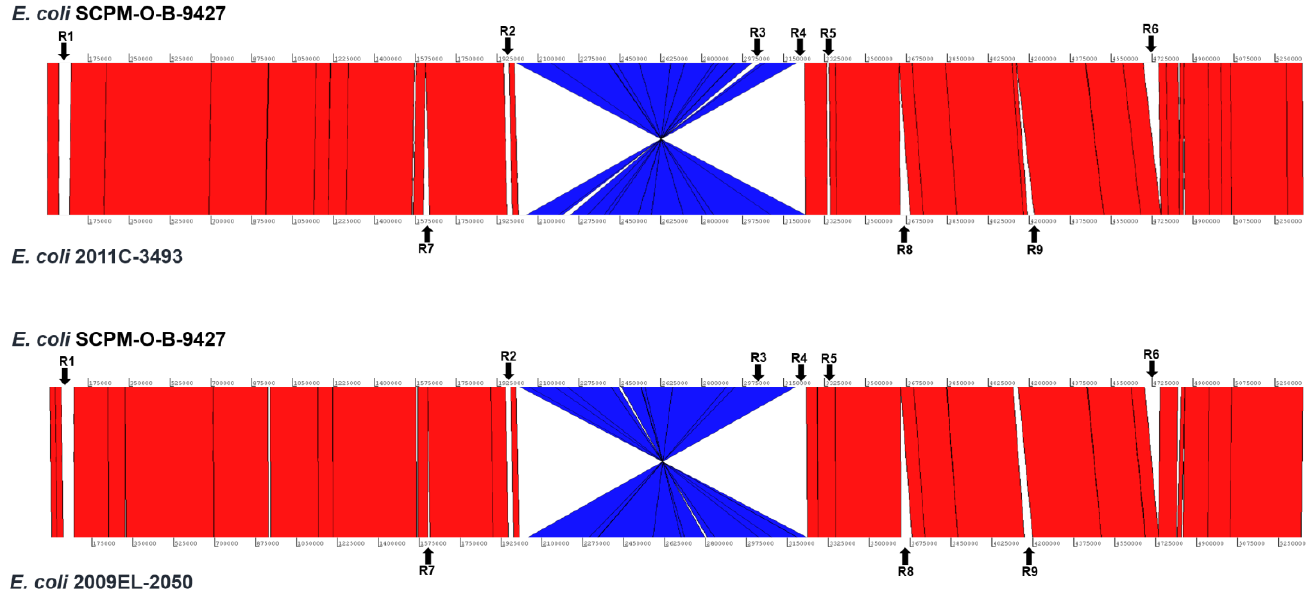
Figure 2. The Artemis comparison of the strain SCPM-O-B-9427 chromosome with chromosomes of the strains 2009EL-2050 and 2011C-3493. Red vertical lines correspond to the regions that are highly homologous and are oriented in the same order, and blue vertical lines depict a region whose orientation is reversed between strains. Arrows on the top and bottom indicate white lines showing that unique regions are non-homologous or are absent in another strain. Table 3. Feature of unique regions of EAHEC strains SCPM-O-B-9427, 2009EL-2050, and 2011C- 3493 detected using Artemis.